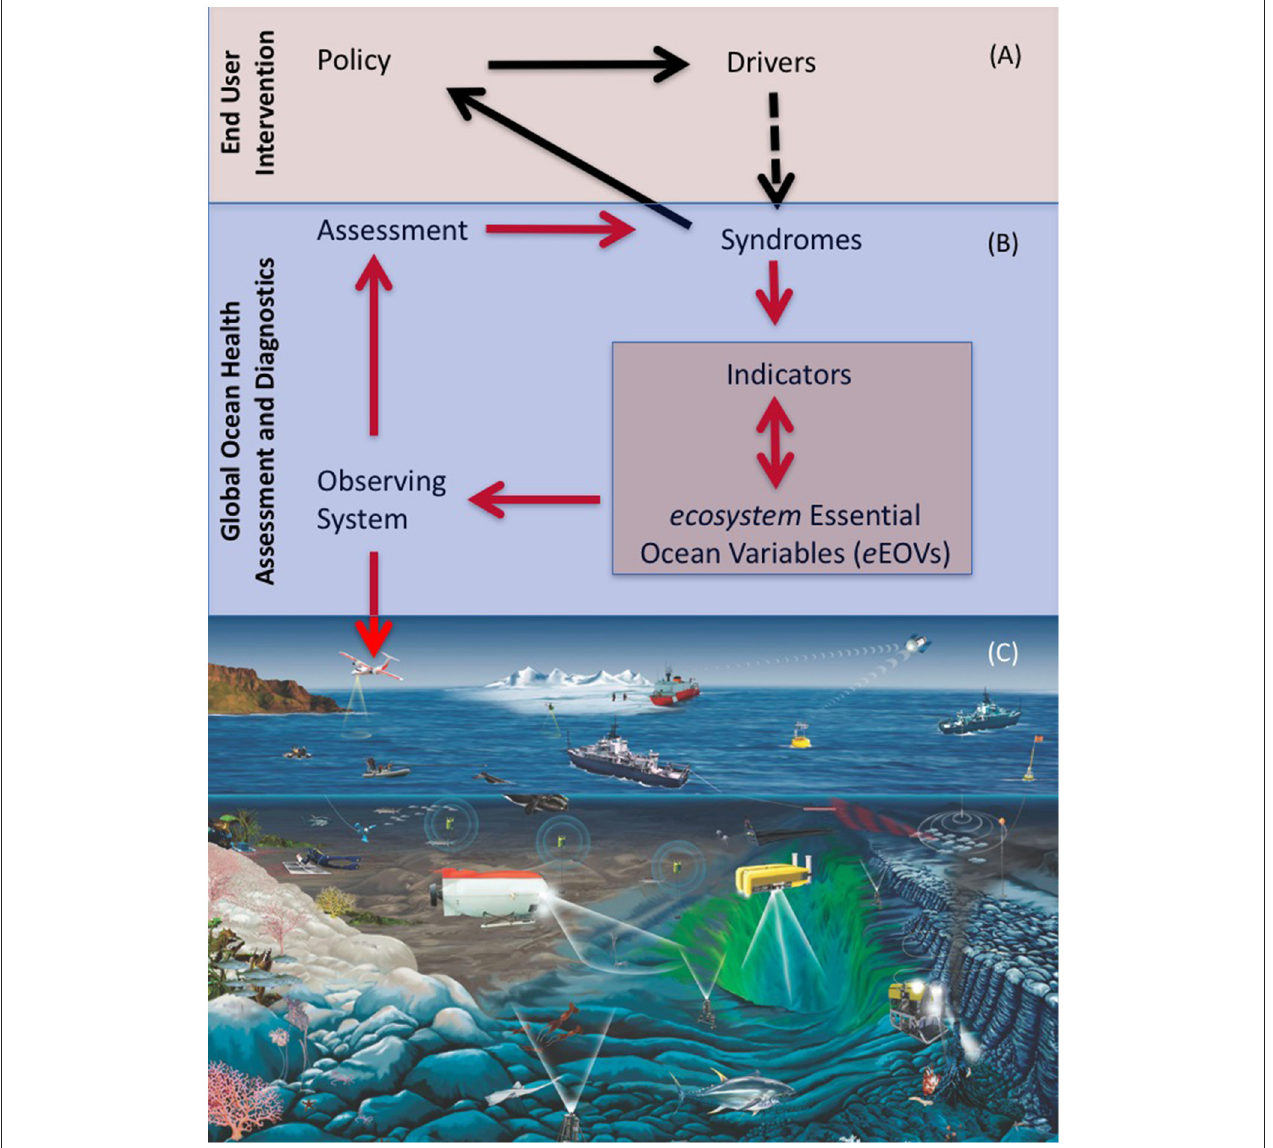
FIGURE 1 | A framework for the global assessment of ocean health identifying the policy actors that take actions to improve ocean health (A) on the basis of diagnostics resulting from the assessment of ocean health (B) , supported by the technology and observational platforms required to deliver the data on the ecosystem Essential Ocean Variables informing the process (C) . Black arrows identify feedback between diagnostics and policy and managerial intervention, and red arrows identify inputs and interactions within the ocean health assessment process. Image (B) by E. Paul Oberlander, provided courtesy of the Census of Marine Life and reproduced with permission under the terms of the Creative Commons Attribution